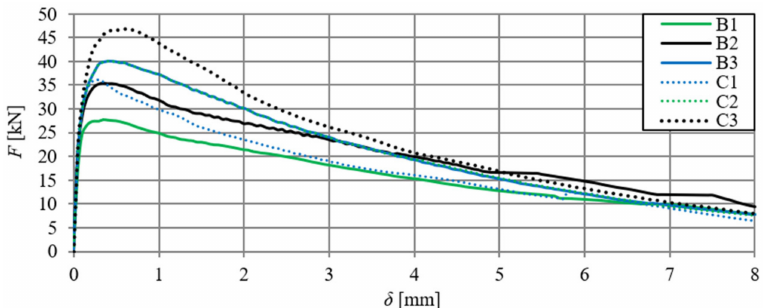
Figure 6. Force–deflection relationships for SFRHSC beams (B and C series, curve C2 coincides with curve B3).